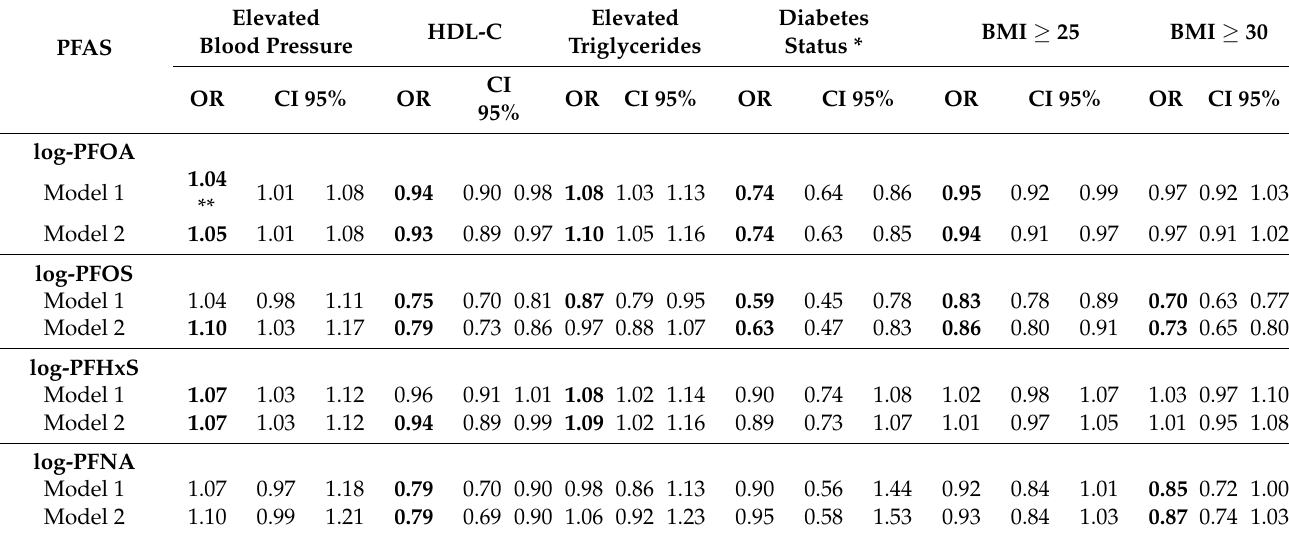
a Model 1 adjusted age, gender, Time-lag between the beginning of the study and blood sampling center where BP has been measured, Education, Number of deliveries, Physical activity, Country of birth, Diet, alcohol intake, and smoking status; Model 2 adjusted for Model 1 + other components of the metabolic syndrome. * Diabetes statues includes participants with HbA1c ≥ 6.1% ( ≥ 43 mmol/mol) or self-reported diabetes or drug treatment of elevated glucose (hypoglycemic medicines). ** The bold values are indicating the statistically significant associations ( p <